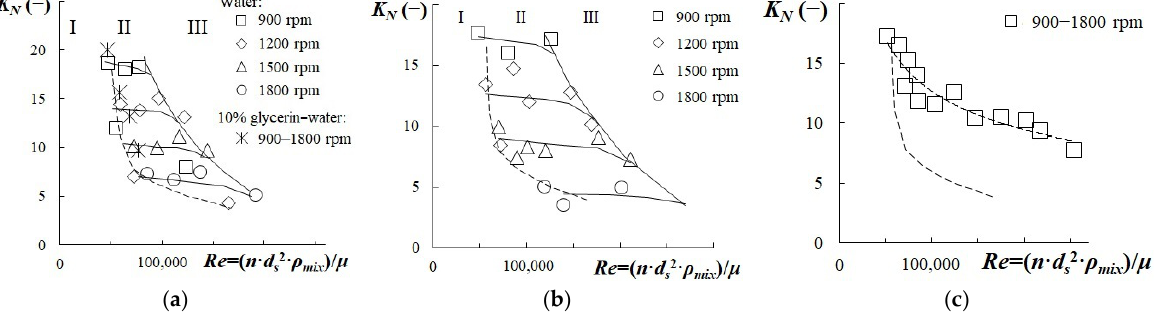
Figure 15. Dependence of the power criterion on the Reynolds number at H L / D = 1.2, D = 0.28 (m), water temperature 13–60 ° С , for different rotational speed: ( a ) one partition; for water ( b ) two partitions and ( c ) three partitions, H L = 0.3 (m); the dotted line is the apparatus without partitions; (I) turbulent operating conditions, (II) bubble operating conditions and the region of developed turbulent interaction (III).